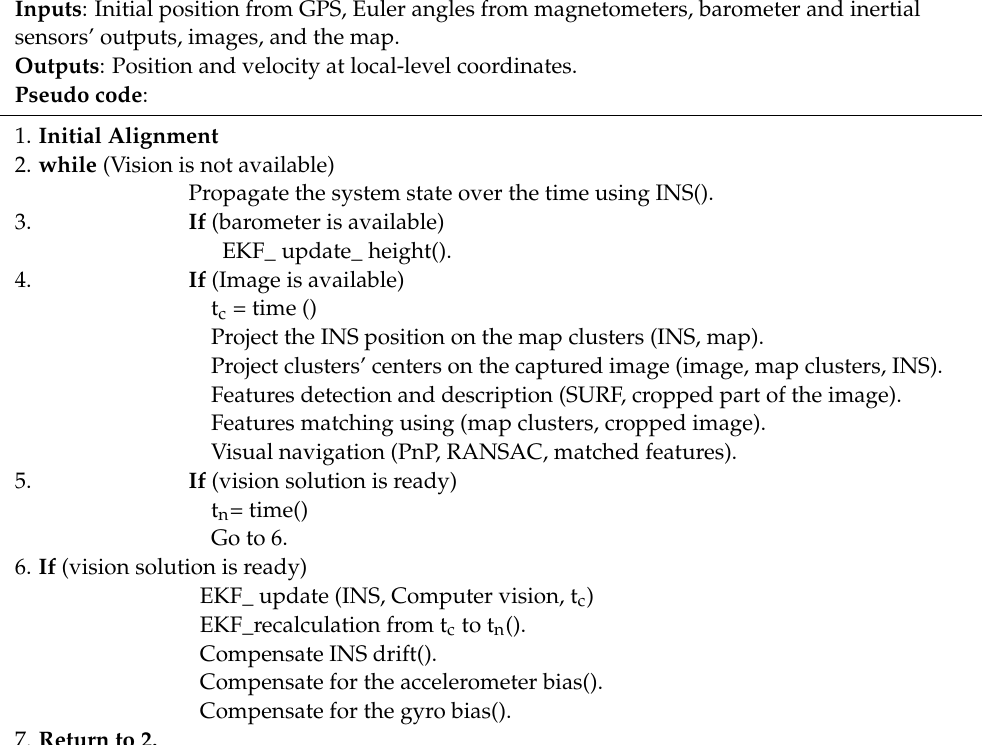
Figure 6. Kalman filter process diagram. Where “ Kg ” is the Kalman gain; “ Q ” is the process noise covariance matrix determined by the inertial sensor’s specification; “ R ” is the measurement noise covariance matrix; “ P ” is the state noise covariance matrix; “ Z ” are the measurements (which should agree with “ D ” as it is sequential filtering) either from the barometer or from the visual system, as shown in Equations (3), (4), and (8). Algorithm 1. The integrated navigation